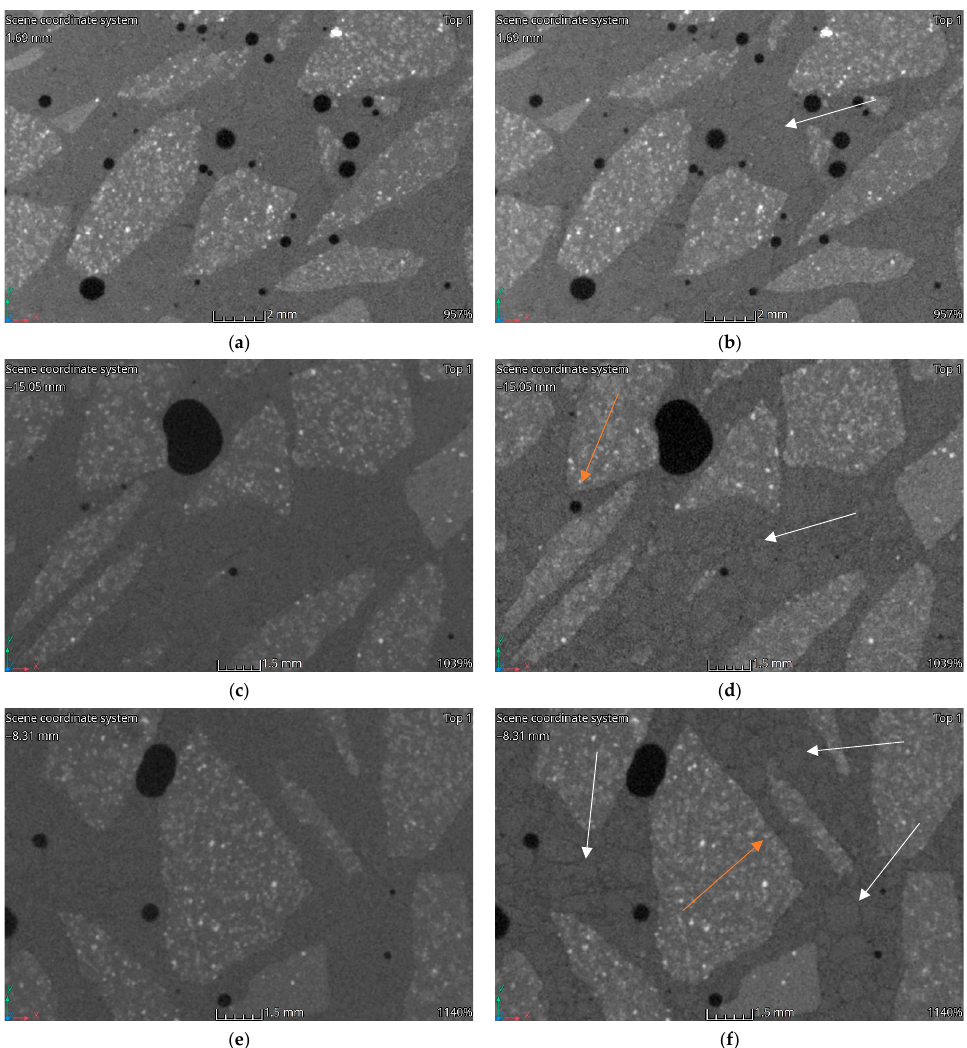
Figure 15. CT imaging results. Structural changes in three samples HPFRC 1.1: ( a ) 20 °C; ( b ) 200 °C; ( c ) 20 °C; ( d ) 400 °C; ( e ) 20 °C; ( f ) 600 °C. ( c ) 20 ◦ C; ( d ) 400 ◦ C; ( e ) 20 ◦ C; ( f ) 600 ◦